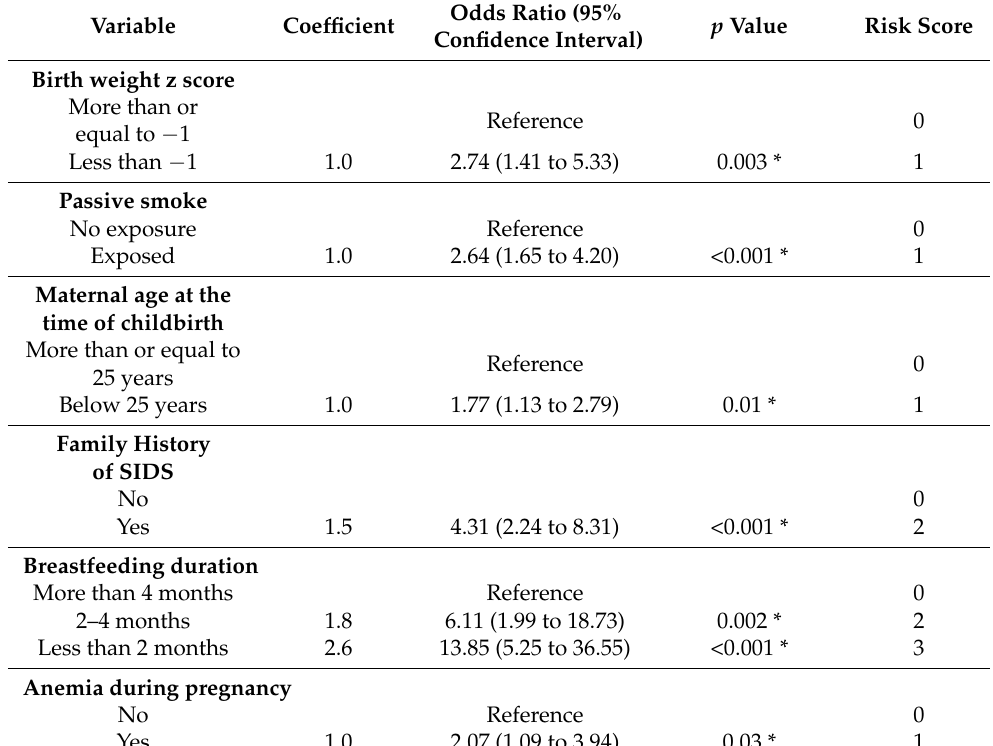
Table 4. Final Prediction Model for SIDS and Risk